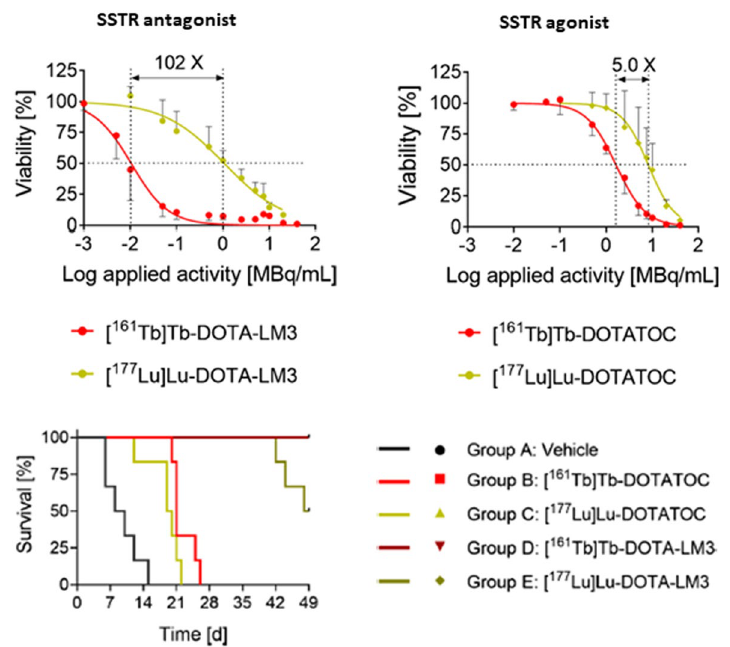
Fig. 2 AR42J tumor cell viability (MTT assay) and Kaplan–Meier plot (2 177 Lu-labeled SSTR agonists (DOTATOC) and antagonists (DOTA-LM3) in AR42J tumor-bearing mice. (adapted from Borgna et al.